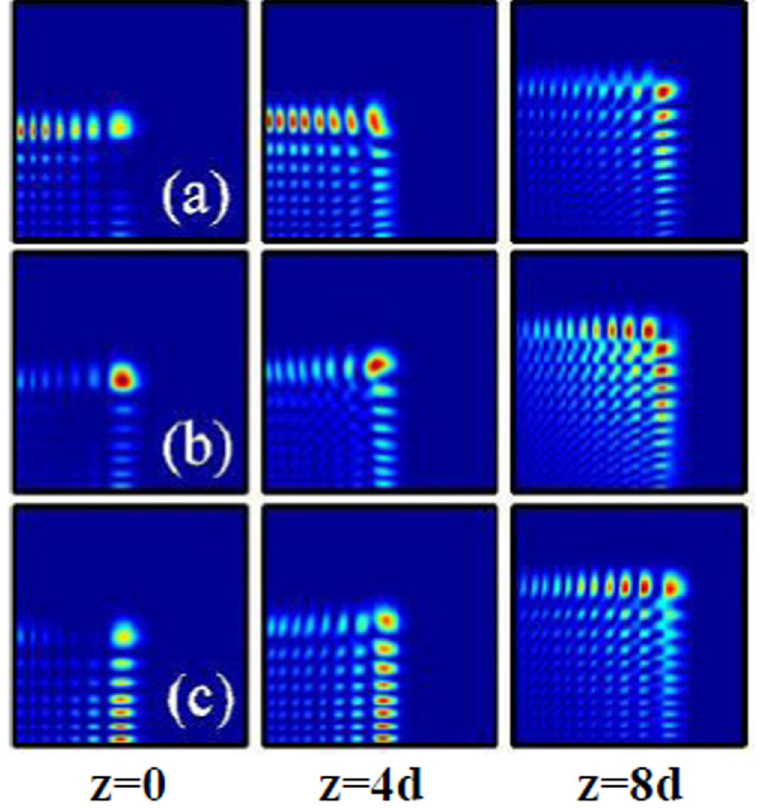
Figure 4. The intensity distributions of a vortex Airy beam at different propagation distances in local self- focusing nonlinear media ( σ = 0). The amplitude and the topological charge of the beam are A = 2 and m = 1. The location of the vortex are ( a ) x 0 = 0, y 0 = 2, ( b ) x 0 = 2, y 0 = 2, and ( c ) x 0 = 2, y 0 = 0, respectively.